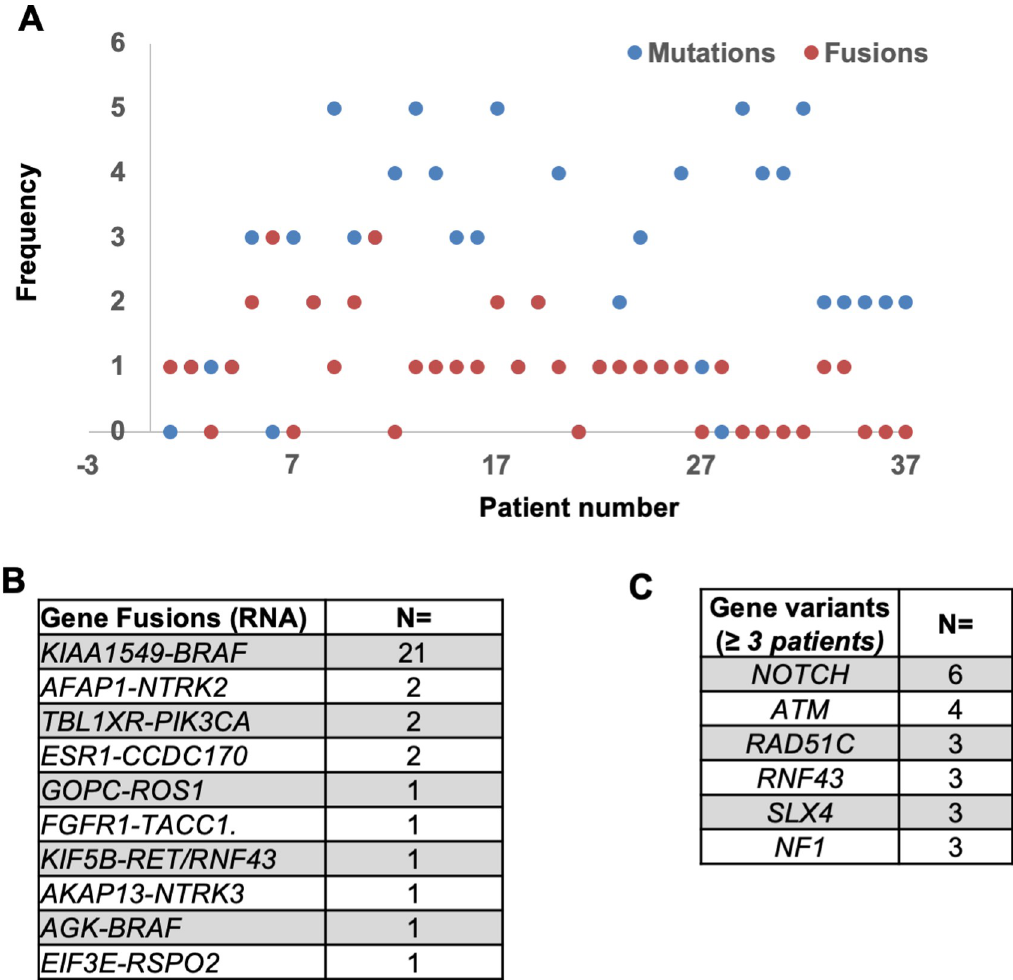
Fig 3. Genetic landscape of the pLGG tumors. (a) Number of genetic mutations and gene fusions observed across the cohort, (b) gene fusions observed in the pLGG tumors, (c) Mutational burden of the LGG tumors.